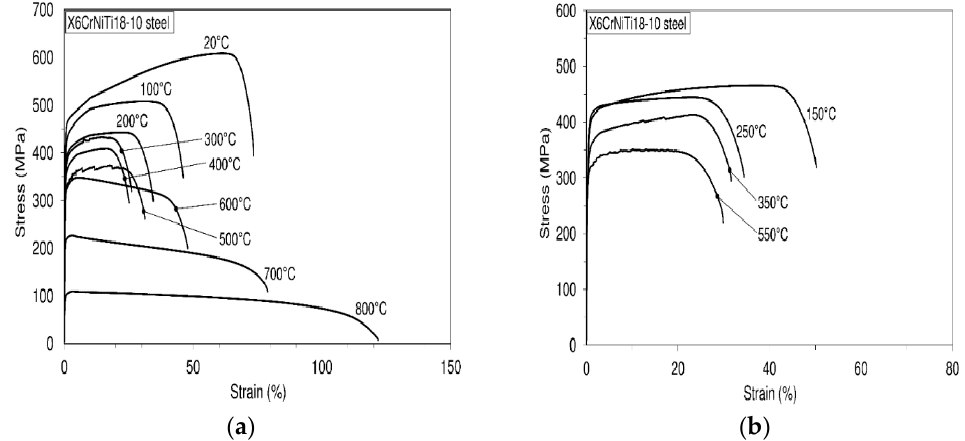
Figure 2. Engineering stress-strain diagrams at room and high temperatures: X6CrNiTi18-10 steel. ( a ) Stress-strain diagrams: 20 °C to 800 °C; ( b ) Stress-strain diagrams: 150 °C to 550 °C.